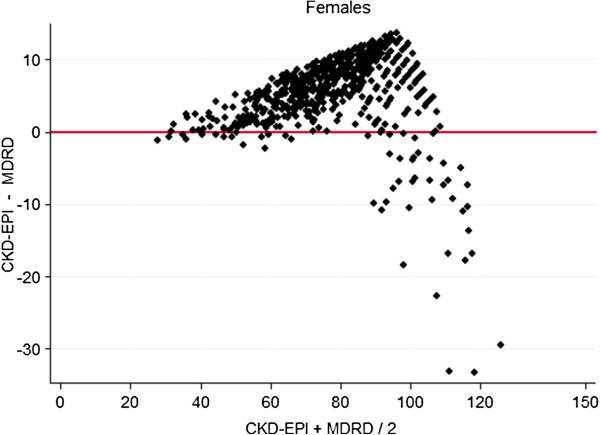
Bland Altman Plots (X axis mean CKD-EPI, MDRD, Y axis CKD-EPI − MDRD) in females.